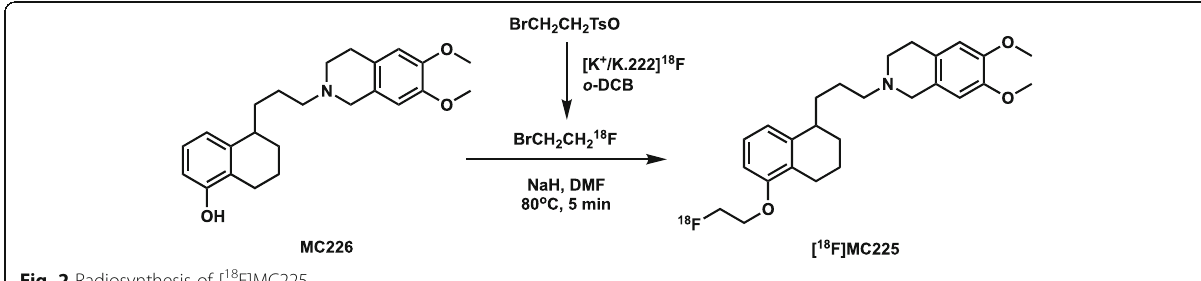
Fig. 2 Radiosynthesis of [ 18